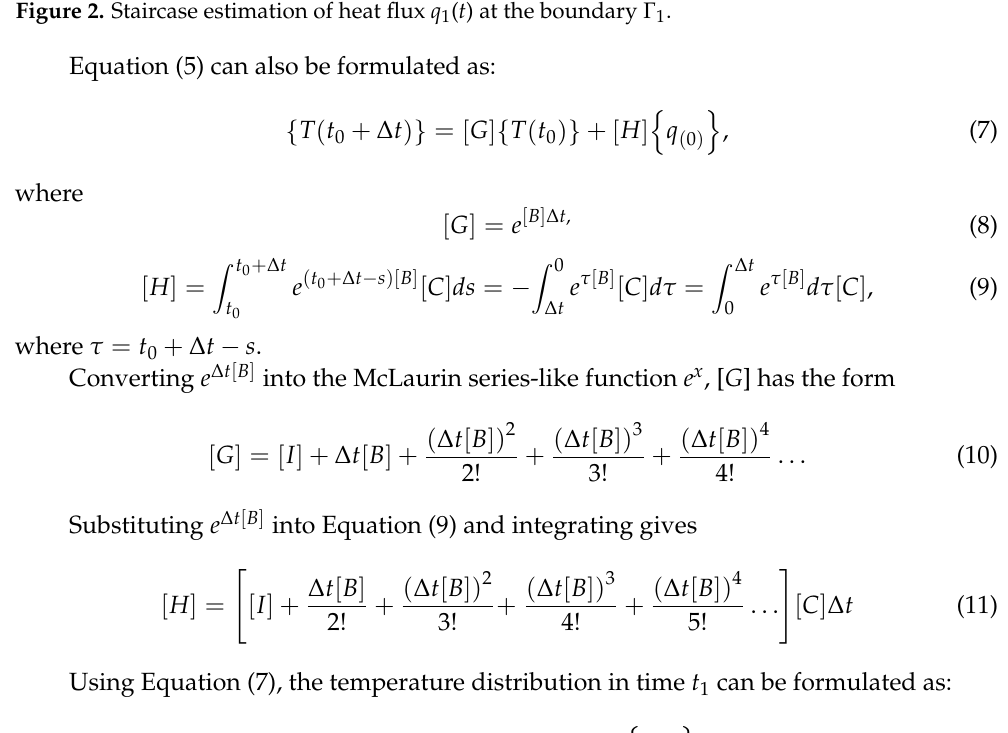
1 ( t ) at the boundary